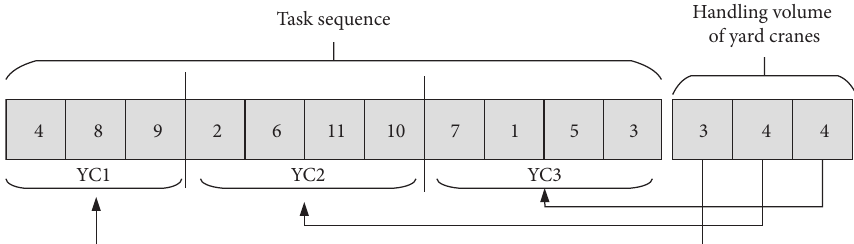
Figure 6: Coding schematic